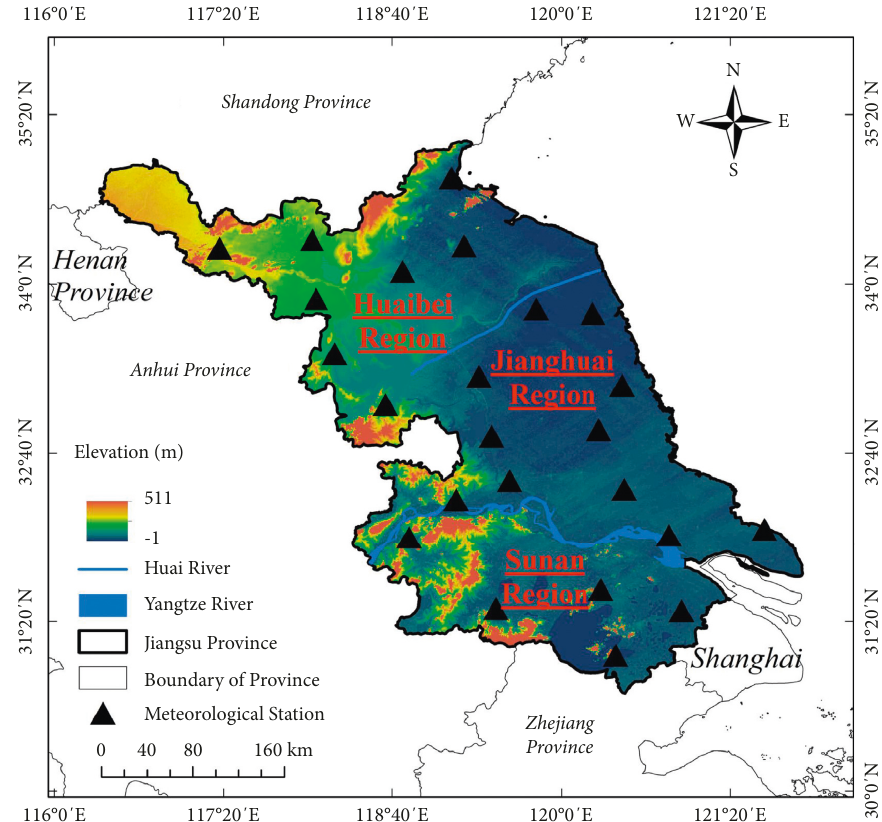
Figure 1: The three regions of Jiangsu province (Huaibei, Jianghuai, and Sunan), rivers, and meteorological